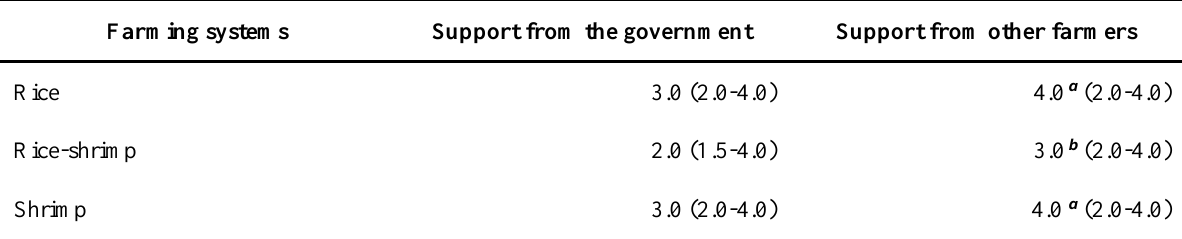
The values in the table represent a “1-5 Likert scale” standing for: very little (1) to very much (5) support. No significant difference of support from the government between farming systems (χ2(2) = 1.34, p = 0.512), significant difference of support from other farmers between farming systems (χ2(2) = 8.28, p = 0.016). The median values with different superscripts are significantly different (p-value<0.05, Dunn’s